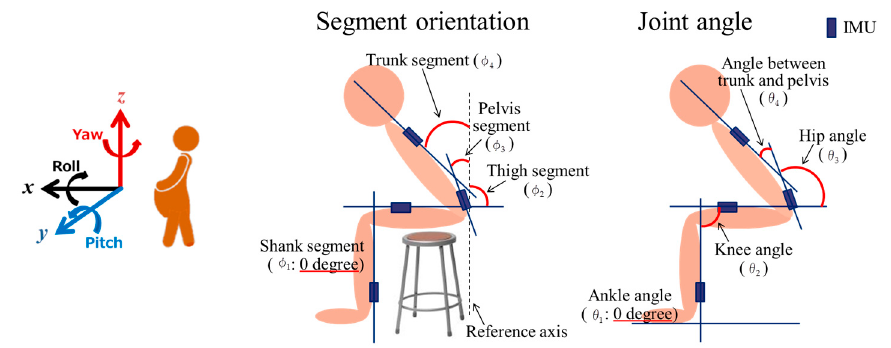
Figure 6. Coordinate system and definition of angles in the